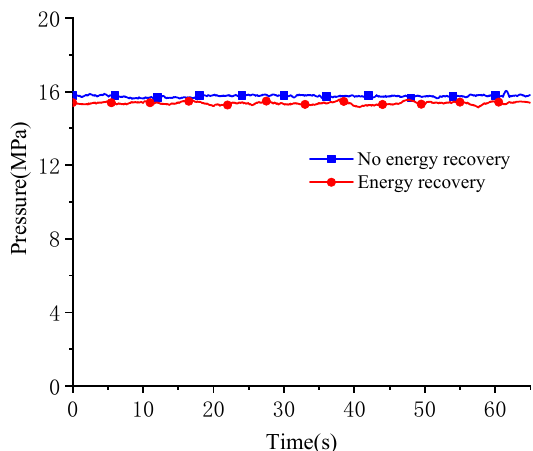
Figure 32. Inlet pressure of the relief valve.